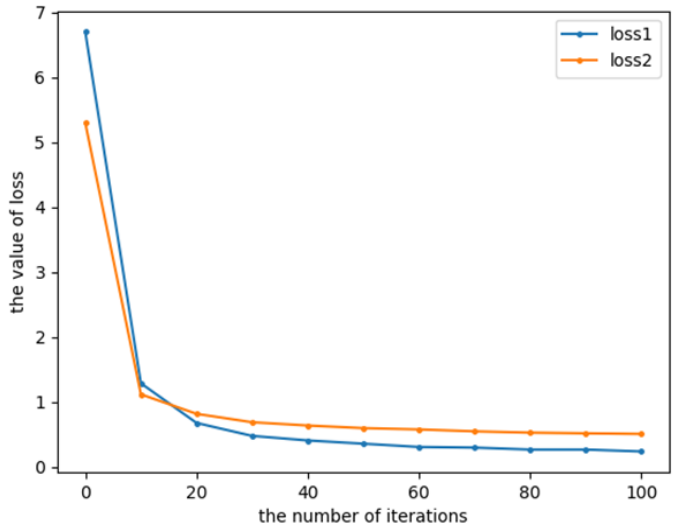
Figure 4. Loss function change.